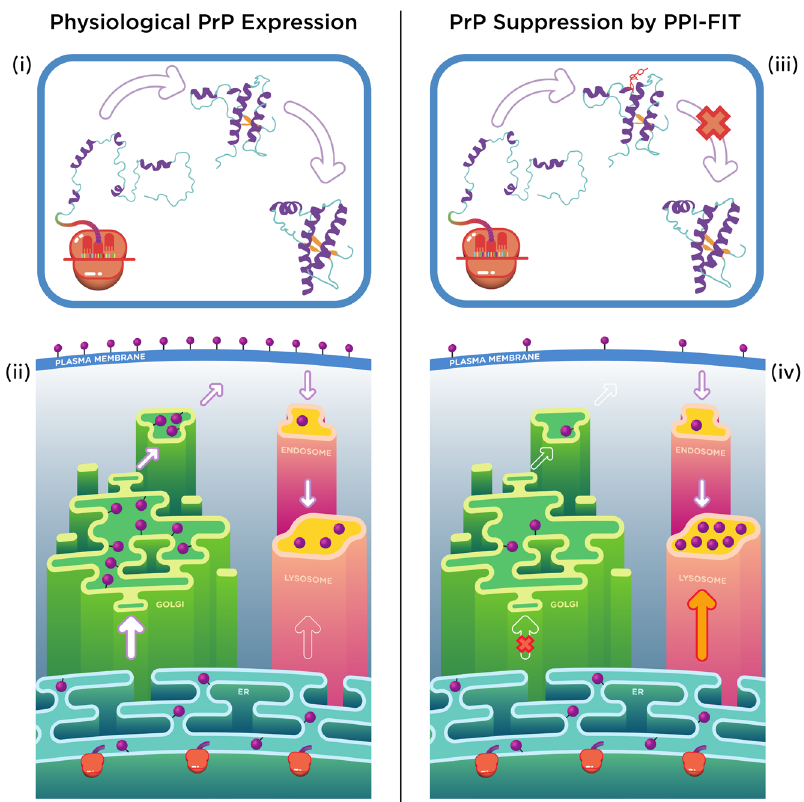
Fig. 8 Model for the PPI-FIT-based suppression of PrP. The model schematically illustrates the rationale underlying the PPI-FIT method applied to PrP. (i and iii) The schematics highlight PrP folding in the presence or absence of a small molecule targeting the PrP intermediate. (ii) PrP follows a typical expression pathway for GPI-anchored proteins. The polypeptide is directly synthesized into the lumen of the ER, once properly folded and post- translationally modi fi ed it traf fi cs to the Golgi apparatus, where sugar moieties are matured, and then delivered to the cell surface. From the plasma membrane, PrP molecules could enter into the endosomal recycling pathways, and eventually recycled into the lysosomes. (iv) Aberrantly folded conformers of PrP, as the case for some previously reported mutant, could be re-routed directly from ER to the lysosomes. In the PPI-FIT method, a small molecule interferes with PrP expression by binding to a folding intermediate, which gets delivered to the lysosomes, leading to an overall decrease of the protein at the cell